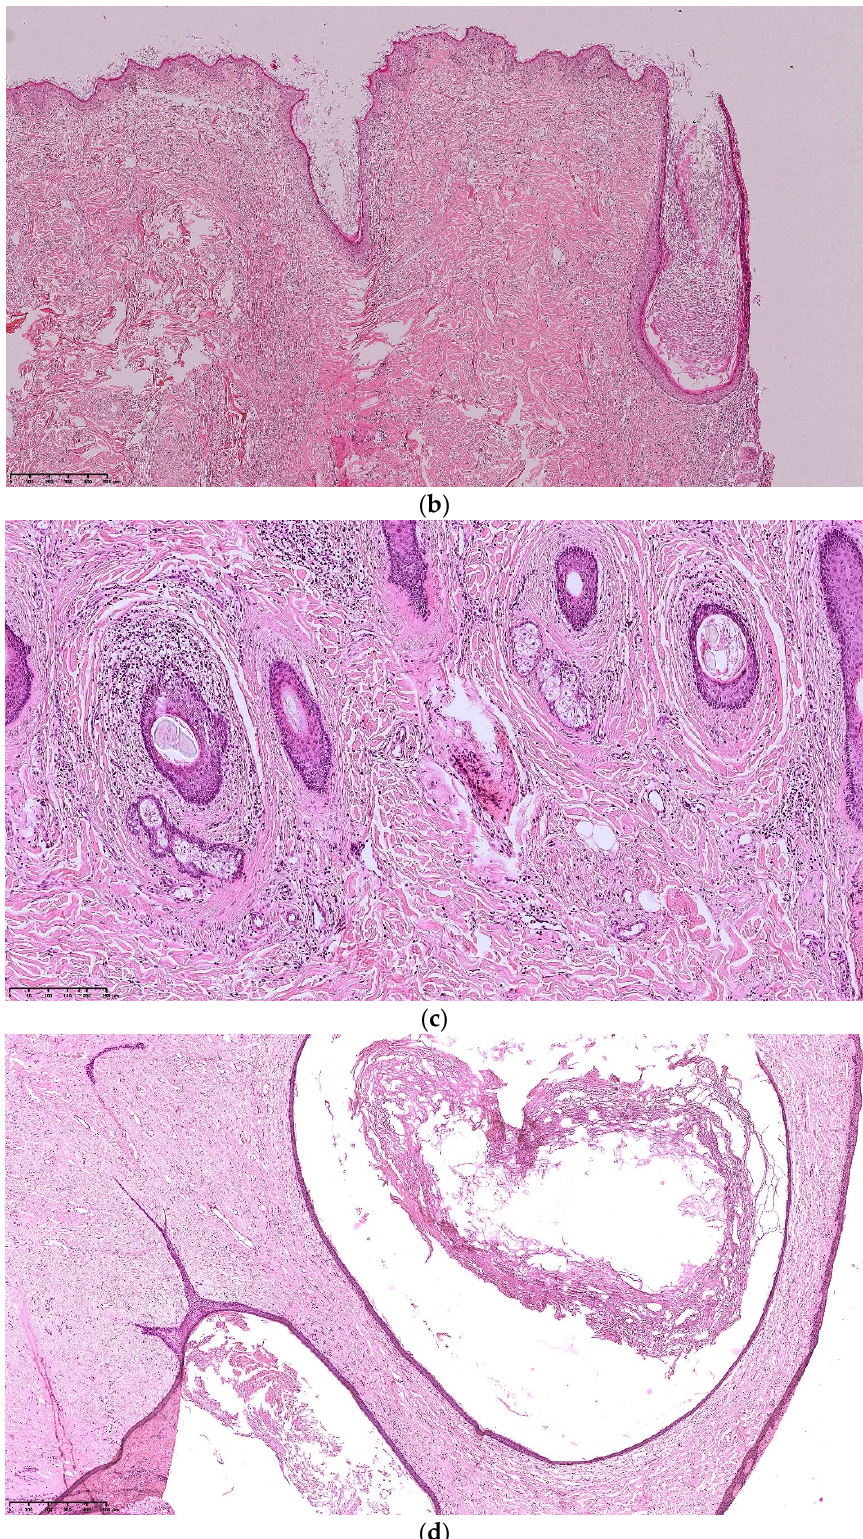
Figure 6. Folliculocystic Hamartoma. ( a ): clinical aspect of an occipital FCCH; ( b ): Hematein eosin ×10: extensive fibrosis and concentric perifollicular fibrosis; ( c ): Hematein eosin ×10: comedo openings; ( d ): Hematein eosin ×10: large infundibular cyst.